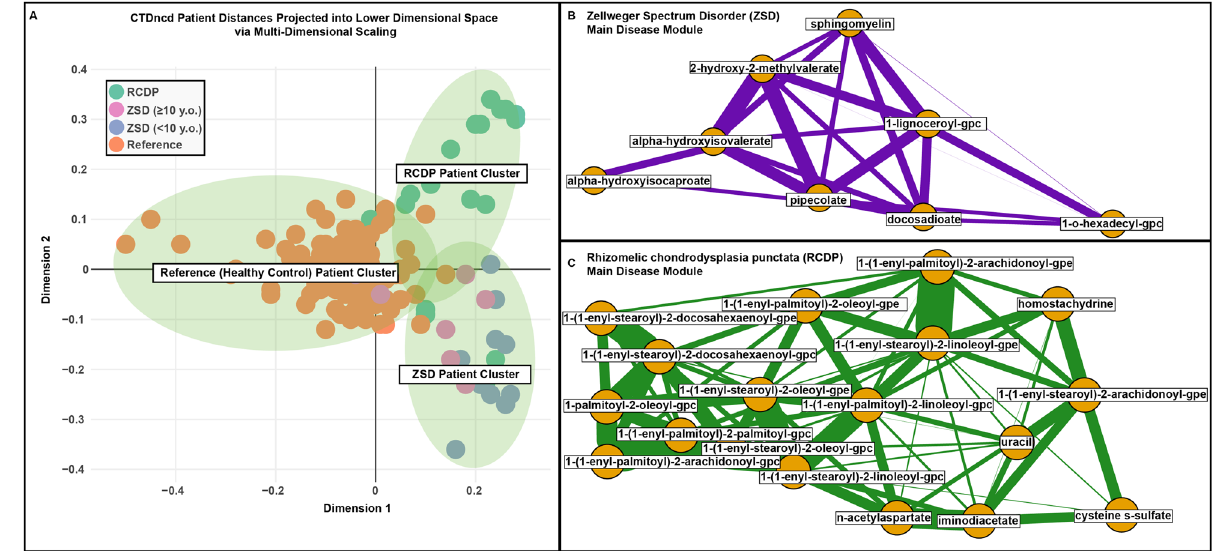
Figure 5. Zellweger spectrum disorder (ZSD), rhizomelic chondrodysplasia punctata (RCDP) and reference (REF) individuals cluster by disease using CTDncd. ( A ) Dots represent individual samples in a lower dimensional 2-D space using multi-dimensional scaling. Individuals are colored by their diagnostic state (e.g., ZSD samples in pink and blue, RCDP samples in green, and reference samples in orange). Within the